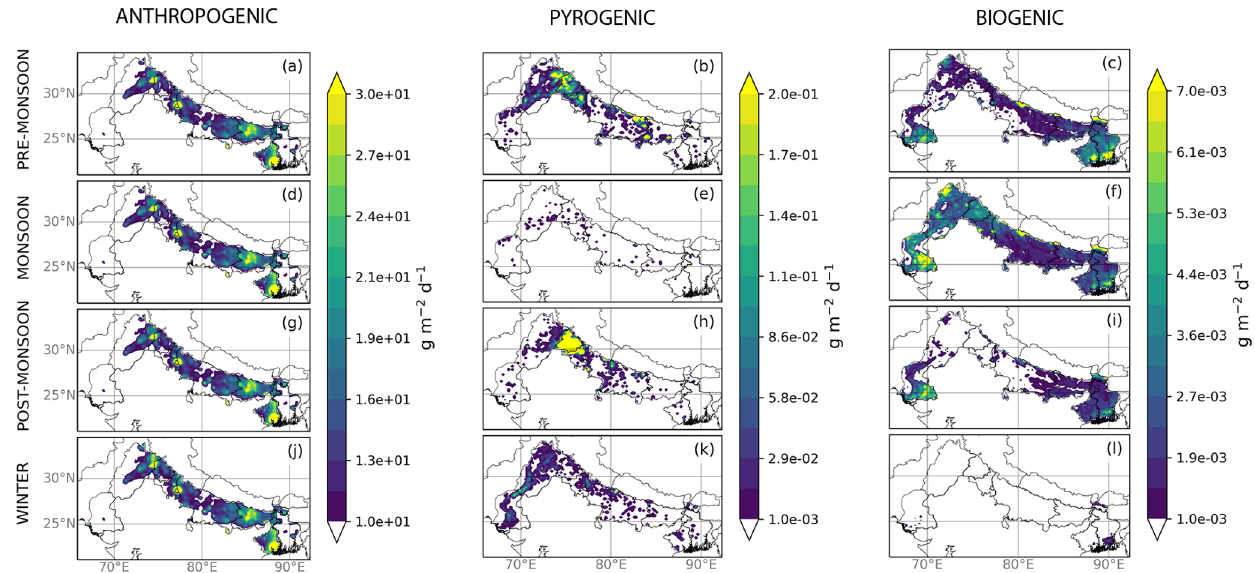
Figure 2. Seasonal mean daily emissions over the IGP (gm − 2 d − 1 ) of (a, d, g, j) anthropogenic, (b, e, h, k) biomass burning, and (c, f, i, l) biogenic (isoprene) emissions. Anthropogenic emissions from EDGAR-HTAP and fire emissions from FINN. Biogenic emissions are calculated online in WRF-Chem using MEGAN. To determine total anthropogenic and pyrogenic emissions, we sum across all emitted species, respectively, while for biogenic emissions, we consider only